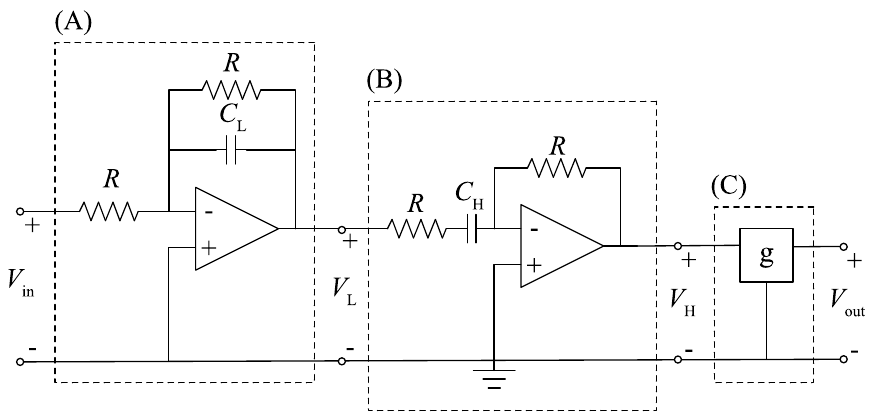
Figure A1. Schematic diagram of an active band-pass filter: ( A ) low-pass filter stage; ( B ) high-pass filter stage; ( C ) noninverting